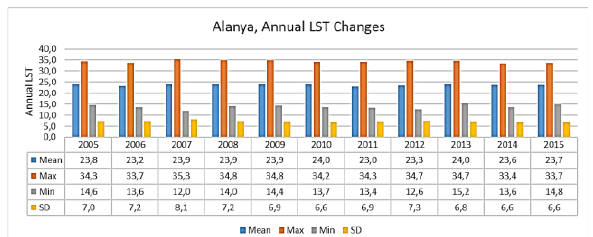
Figure 5. Annual LST change from